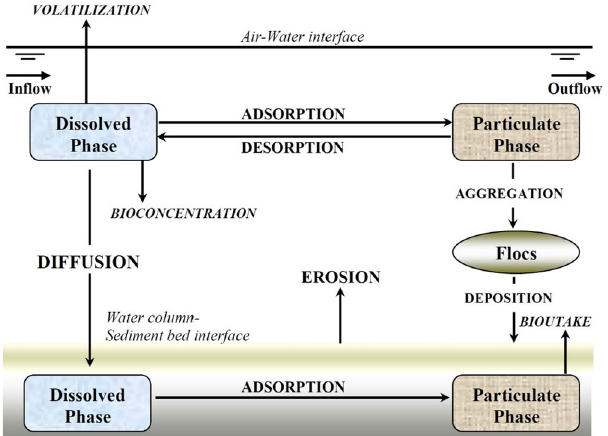
Figure 1. Conceptual model of key processes influencing fate and transport of suspended sediments and associated toxic heavy metals in surface water systems 26